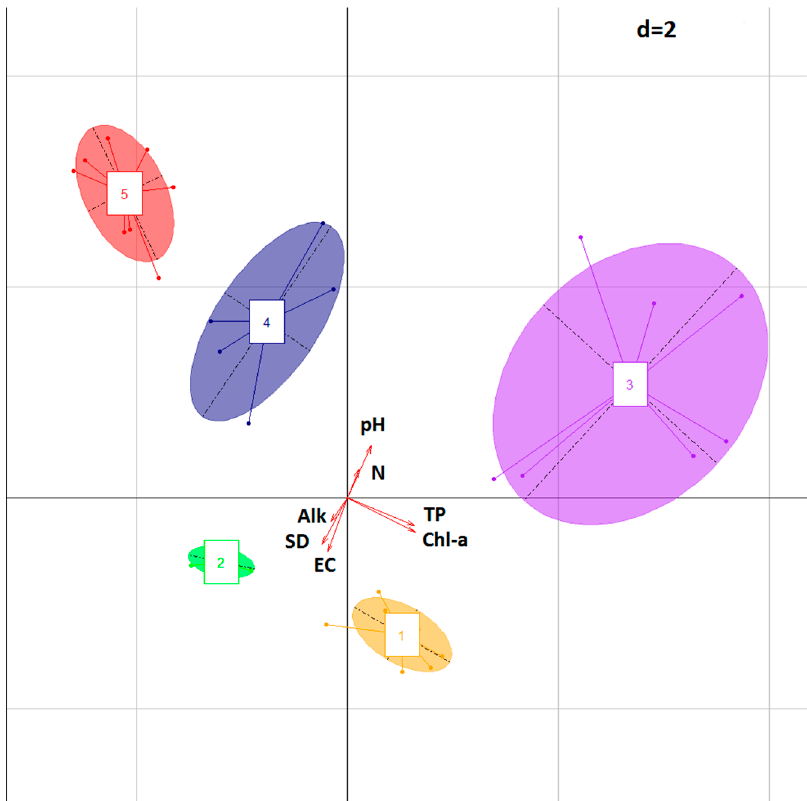
Figure 4. Biplot showing the relationships between the functional macrophyte assemblages derived from hierarchical clustering and the vectors of environmental parameters